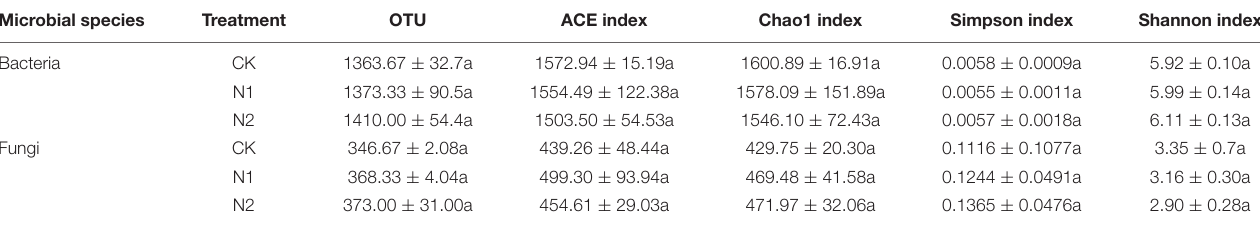
TABLE 2 | Effects of N application on OTU number and diversity index of soil microorganisms. Microbial